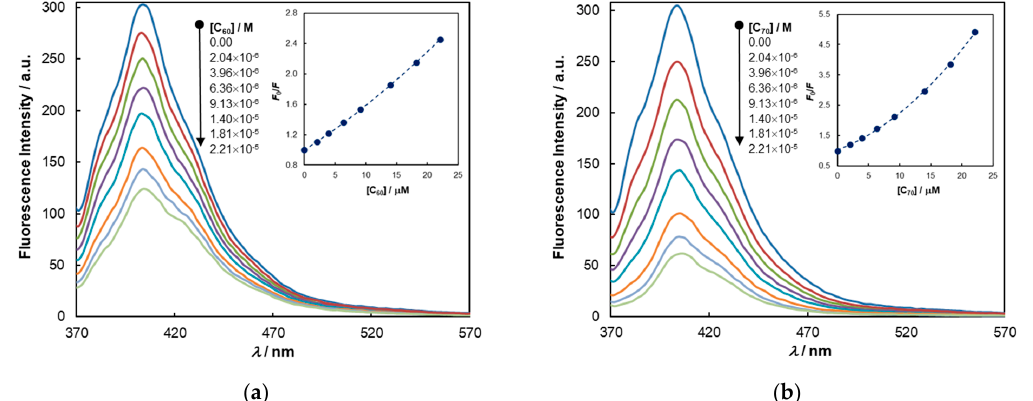
Figure 3. Emission spectra of bis-( p -H-calix-triprop)-3,6-CBZ ( 4 ) (6.0 × 10 − 7 M in toluene; λ exc = 357 nm) after successive additions (2.04 × 10 − 6 – 2.21 × 10 − 5 M) of fullerene C 60 ( a ) and C 70 ( b ). Insets: plots of the changes in the ratio of fluorescence intensity of 4 vs. [C 60 ] and [C 70 ].